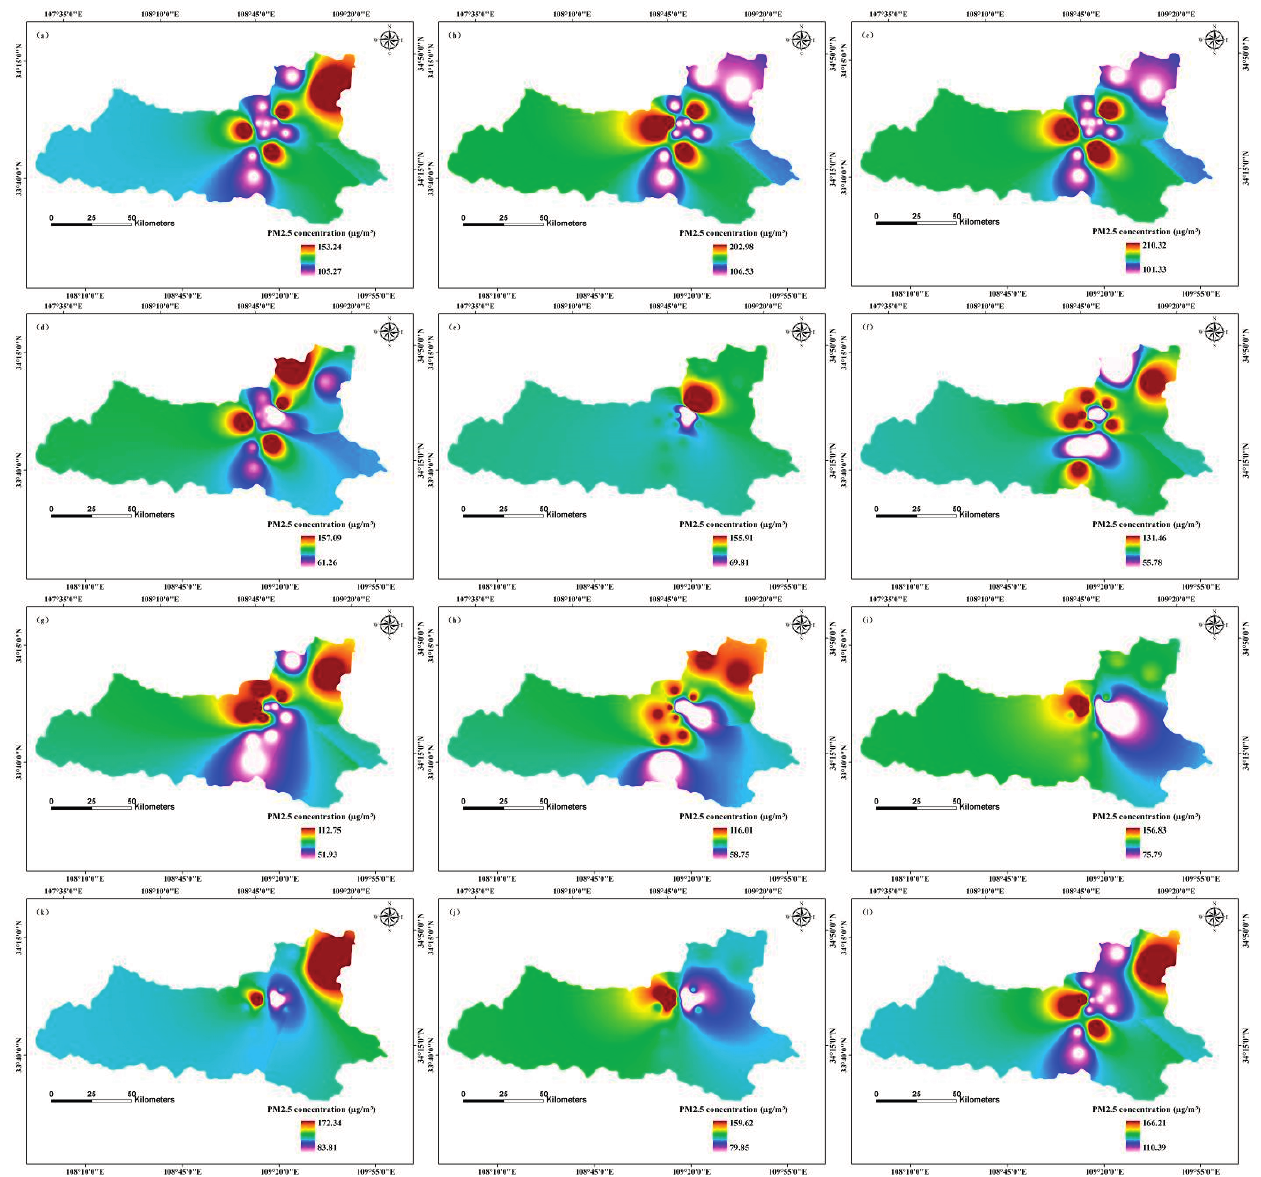
Figure 5. Simulation of temporal and spatial changes of PM2.5 concentration based on a BP-ANN model in 2025, Xi’an, China by month: ( a ) January; ( b ) February; ( c ) March; ( d ) April; ( e ) May; ( f ) June; ( g ) July; ( h ) August; ( i ) September; ( j ) October; ( k ) November; ( l )